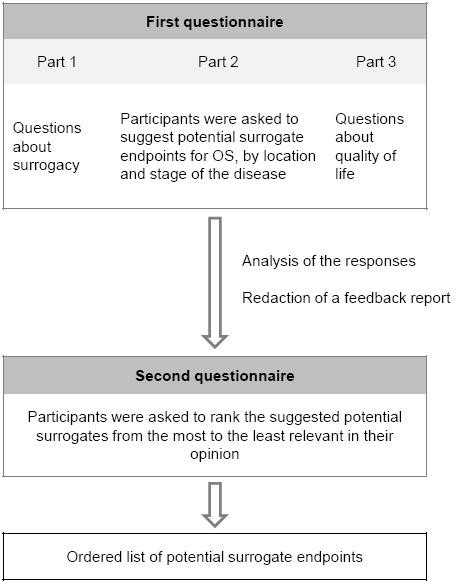
Survey procedure.